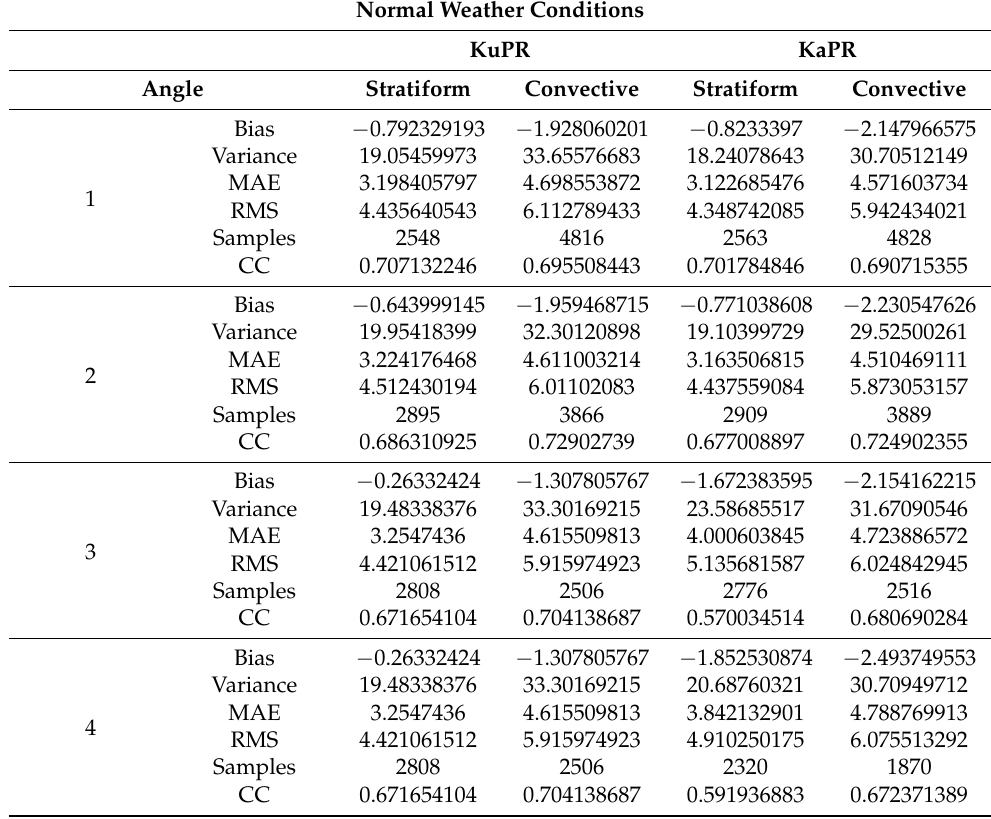
Figure 8. GPM ‐ Ku vs. NEXRAD TJUA for stratiform precipitation (angle 1). Figure 9. GPM ‐ Ka vs. NEXRAD TJUA for convective precipitation (angle 1). Figure 10. GPM ‐ Ku vs. NEXRAD TJUA for convective precipitation (angle 1).